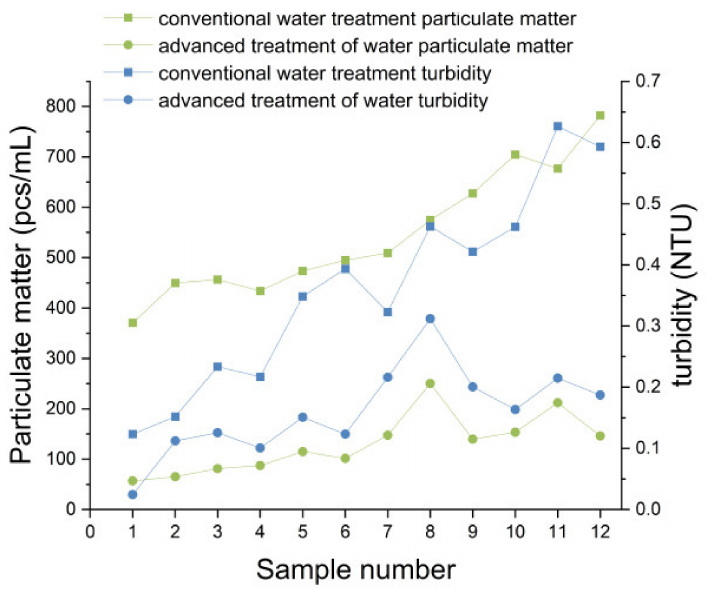
Figure 3. Variation of particulate matter and turbidity in conventional and deep treatment water.